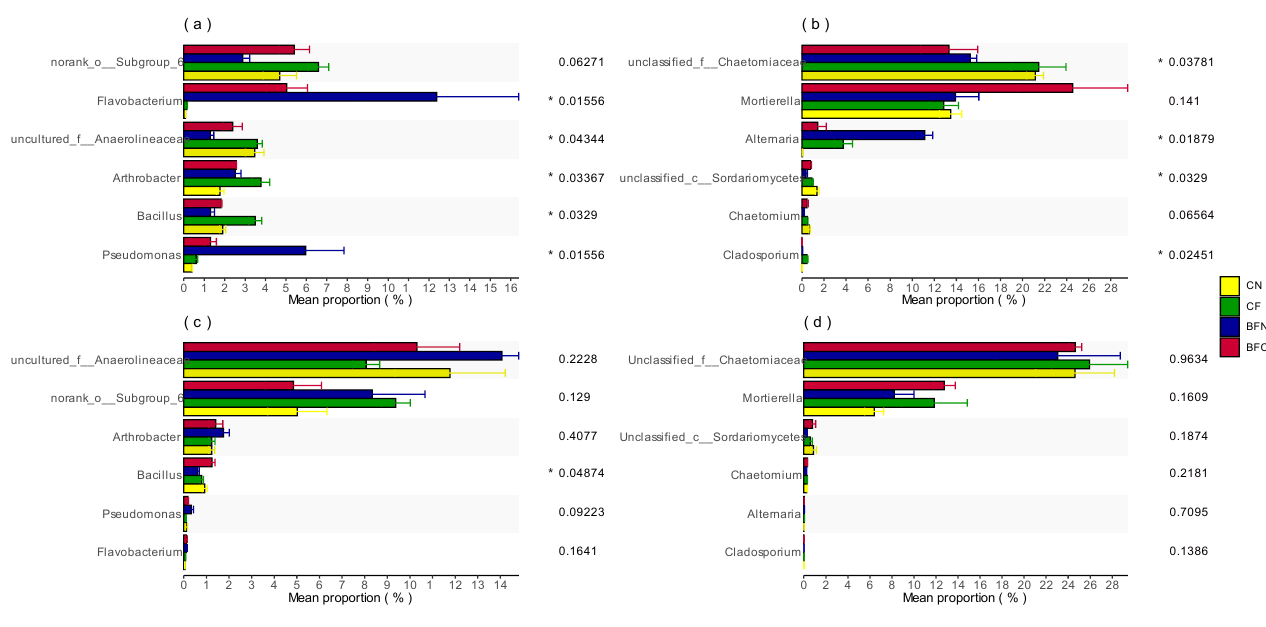
Figure 3. Relative abundance of some selected beneficial soil microbes 15 days after transplanting ( a , b ) and fruiting stages ( c , d ) for bacteria and fungi, respectively ( p ≤ 0.05). The bars in each column are standard errors. Means value (n = 3), * denotes significant difference at p ≤ 0.05.